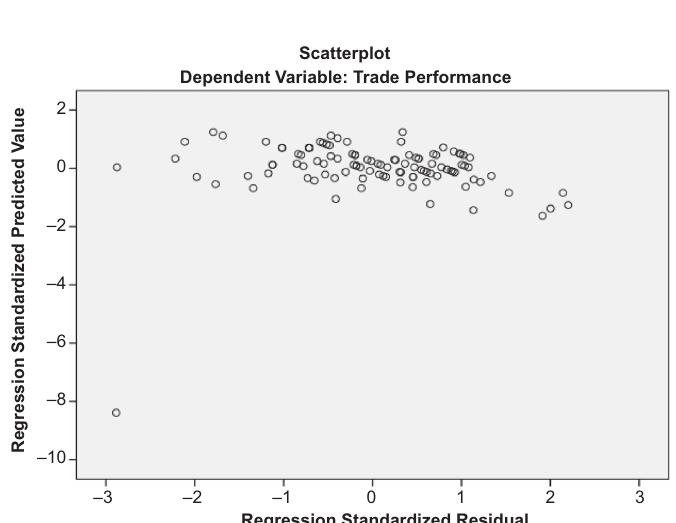
Figure 2. Graphical presentation of linearity test – normal P-P plot